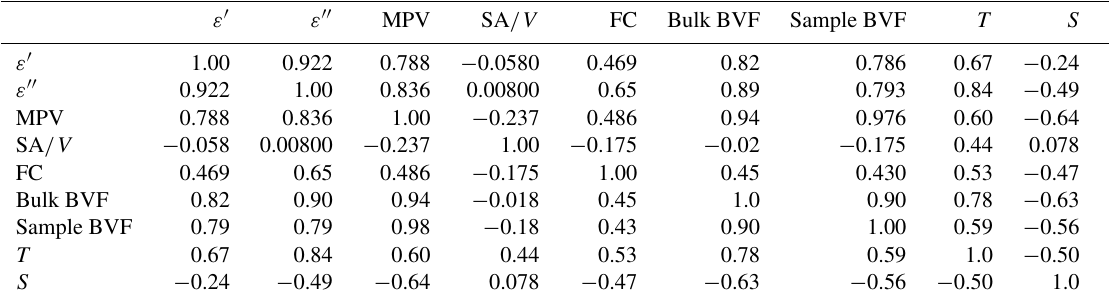
Table 2. Correlation matrix comparing measurements of ε (cid:48) and ε (cid:48)(cid:48) at 10Hz to mean pore volume (MPV), surface area to volume ratio (SA /V ), depth of 25% fractional connectivity (FC), bulk brine volume fraction (bulk BVF), sample brine volume fraction (sample BVF), ice temperature ( T ), and bulk ice salinity ( S ).